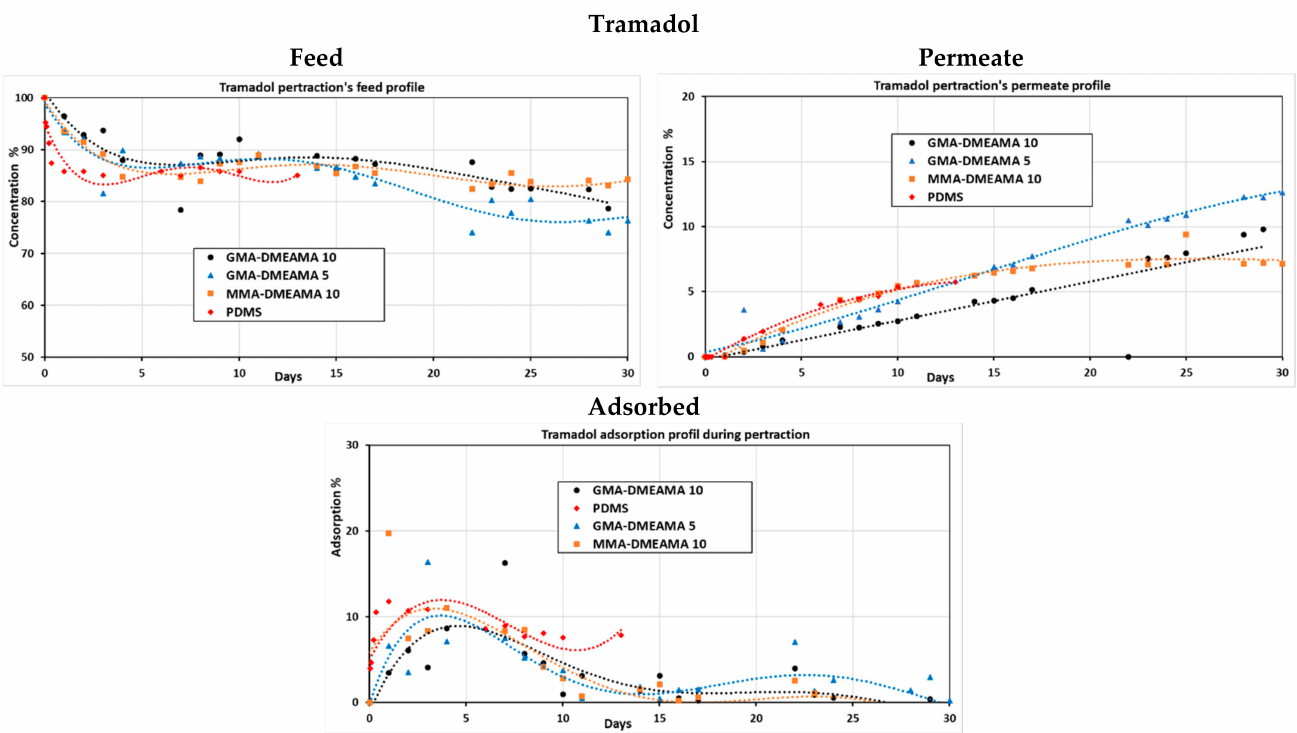
Figure 7. Adsorption, permeate, and feed profiles of the tramadol solution during the pertraction process with bare and modified PDMS